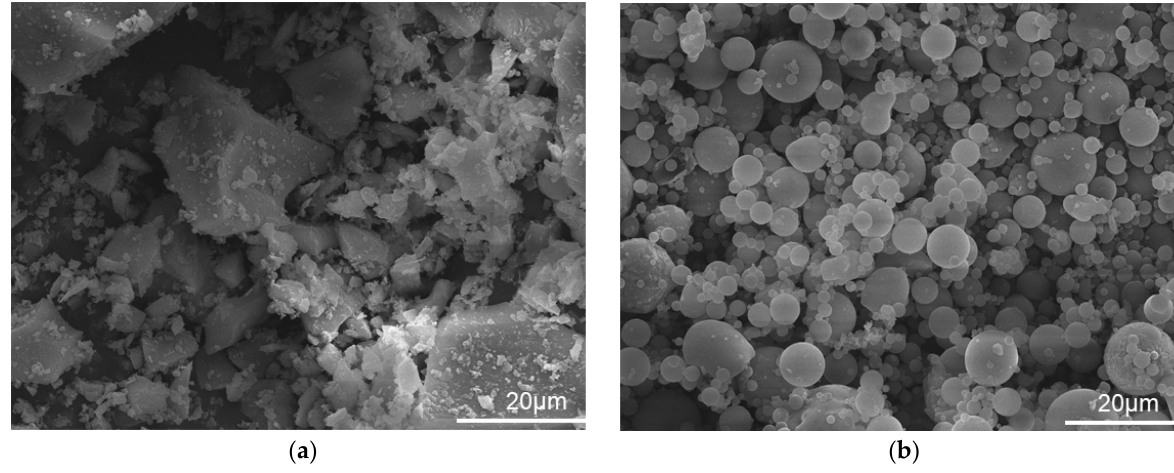
Figure 1. SEM images of ( a ) HMNS and ( b ) FA.